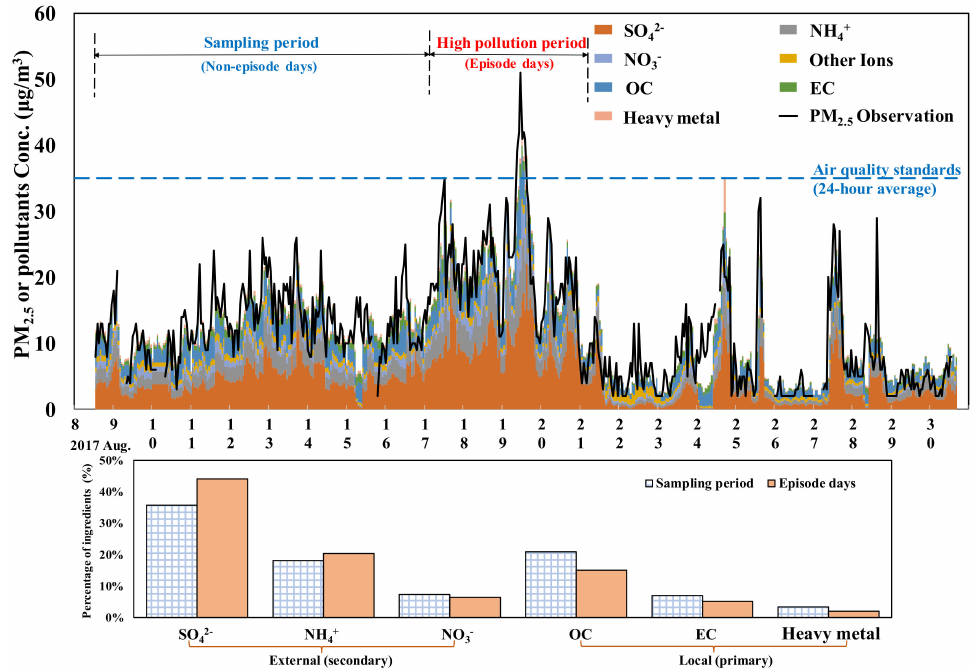
Figure 3. Time series of the concentrations of PM 2.5 and its major chemical components. The other ions include Na + , K + , Mg 2+ , Ca 2+ , Cl − , and NO 2 −